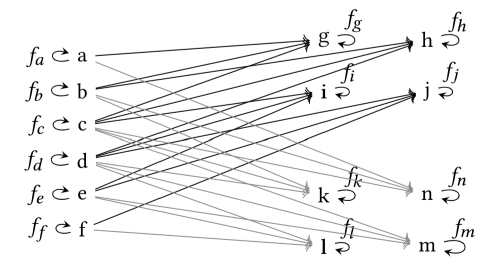
Figure 8. An illustration of a convolutional layer. The black arrows with target g, h, i and j correspond to the first channel, and the gray arrows with target k, l, m and n correspond to the second channel. A change of basis τ ∈ (cid:101) G that preserves the weight architecture of this convolutional layer, has to be of the form τ = ( τ i ) m where τ g = τ h = τ i = τ j and τ k = τ l = τ m = τ n . Note that a convolution is i = a given by filters which share weights, so if the previous condition is not satisfied, after applying the change of basis one will obtain weights that are not shared, so the resulting weights will not fit the definition of a